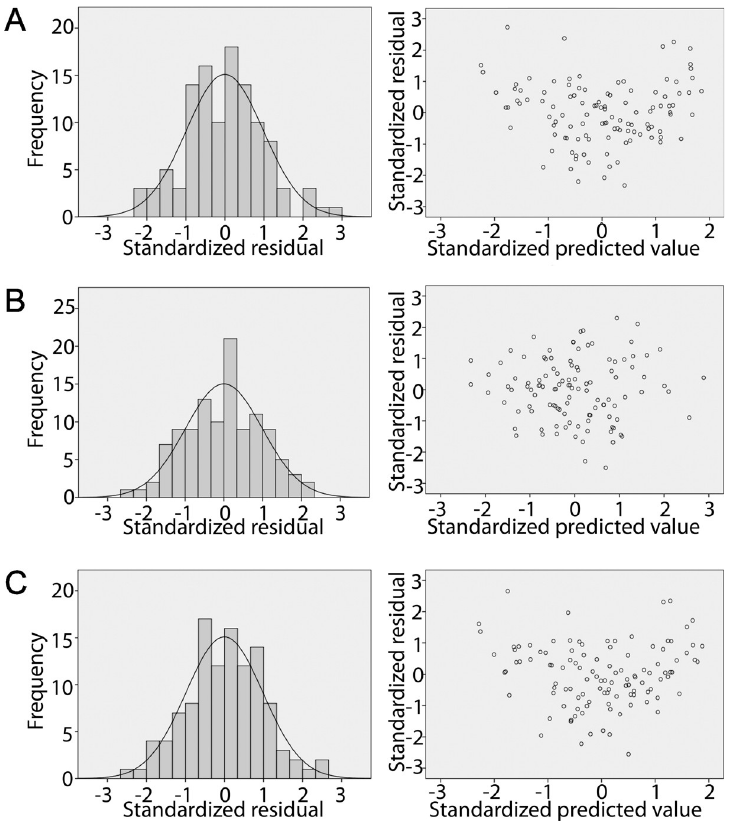
Fig 2. Residual analysis of the regression models. (A) Fy = vertical component. (B) Fx = antero-posterior component. (C) F R = resultant force. Left: Residuals histogram. Right: Dispersion of residuals across predicted values.